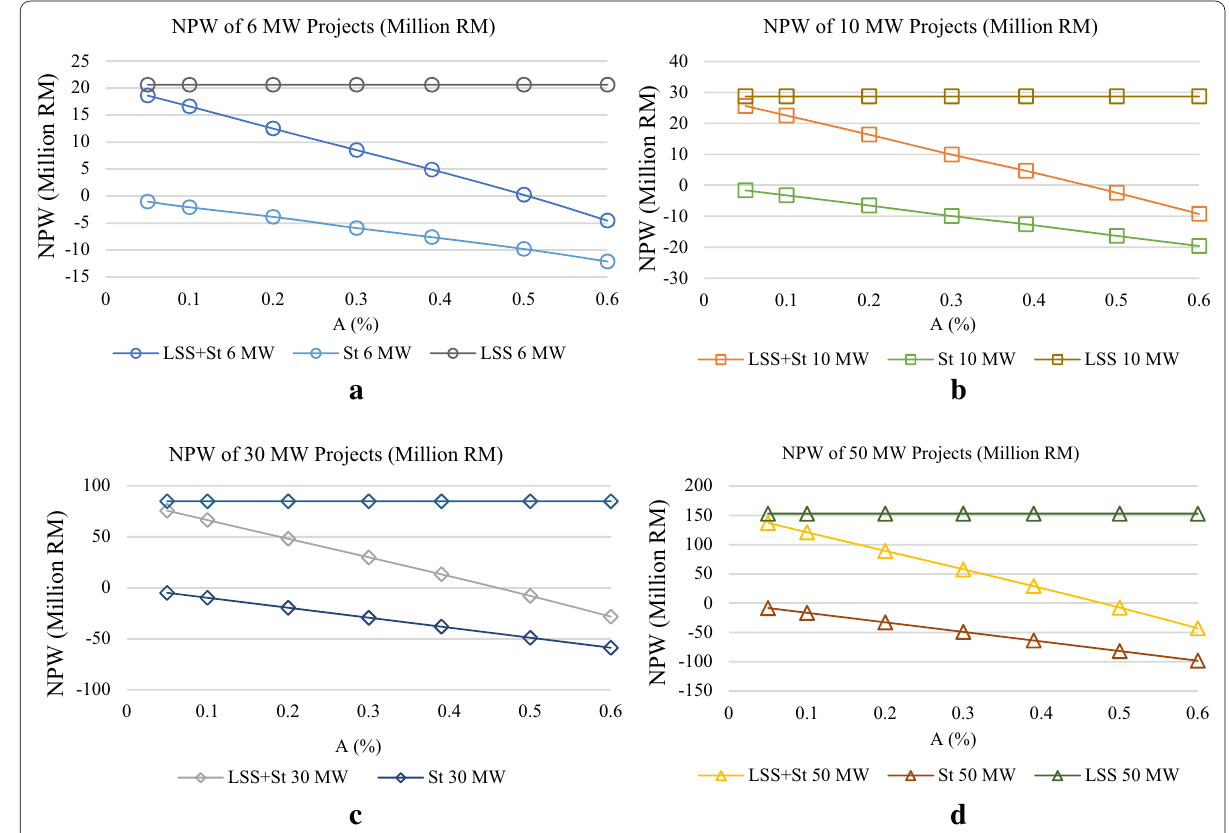
Fig. 12 Net present worth of the different investment types for each LSS capacity in Perak. a 6-MW projects, b 10-MW projects, c 30-MW projects, d 50-MW